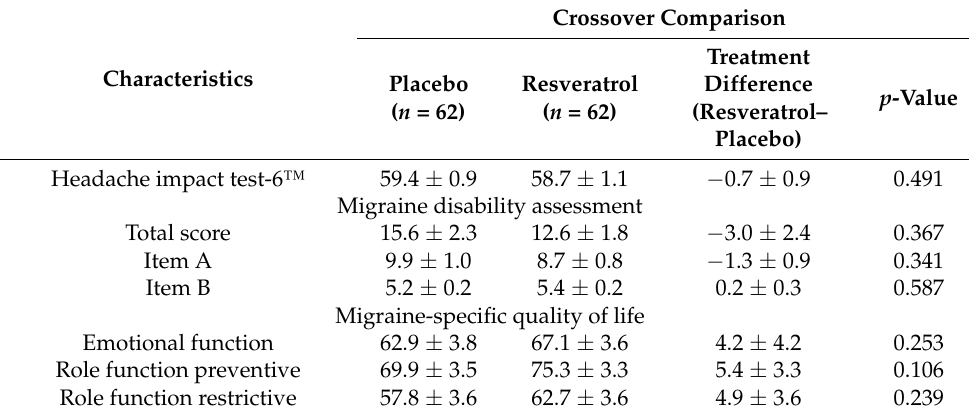
Table 3. Migraine-Related Disability and Migraine-Specific Quality of